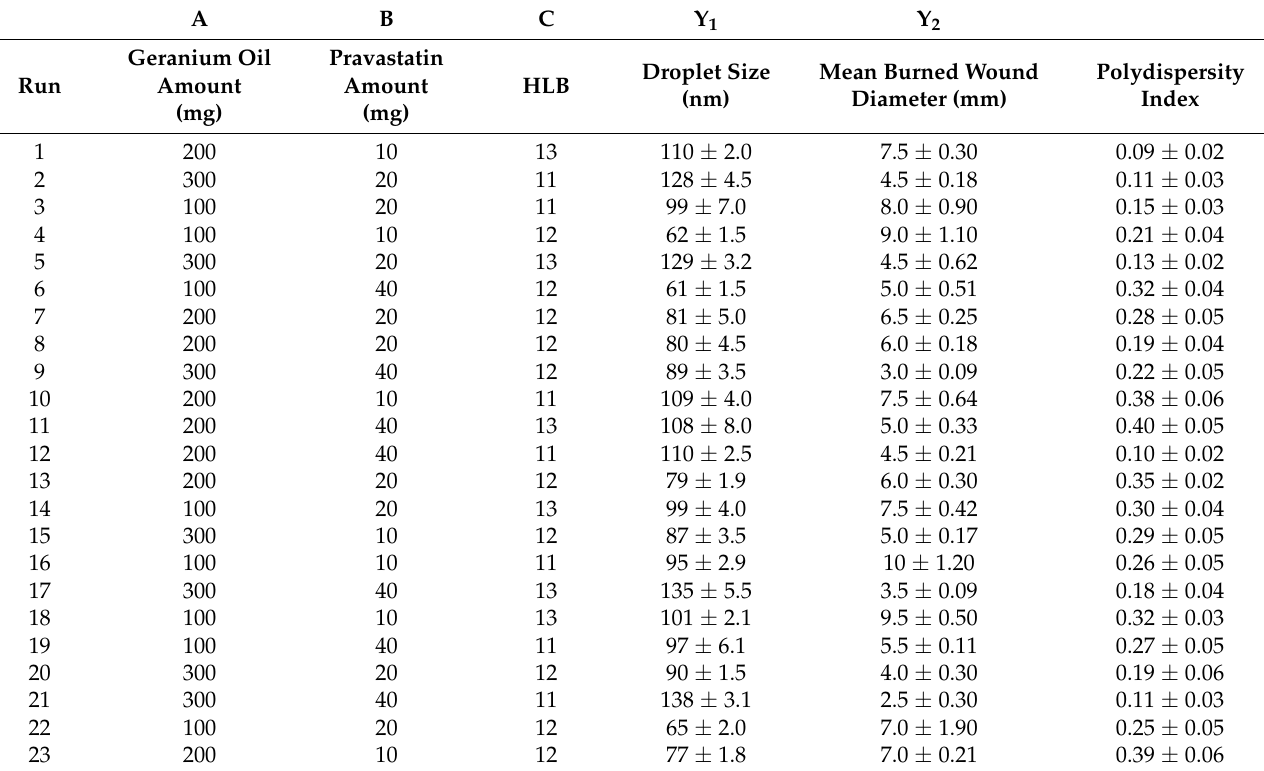
Table 2. BBD and responses of